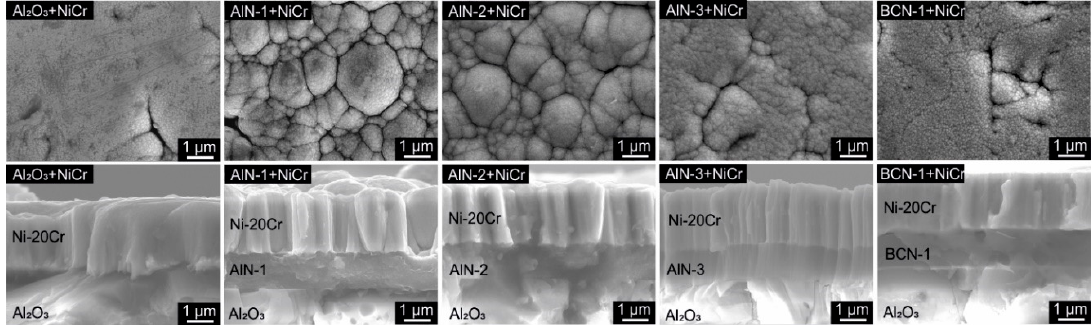
Figure 4. SEM images of the topography ( top ) and cross-section ( bottom ) of Ni-20Cr thin films, deposited on a polished Al 2 O 3 substrate as well as on AlN and BCN thin films.